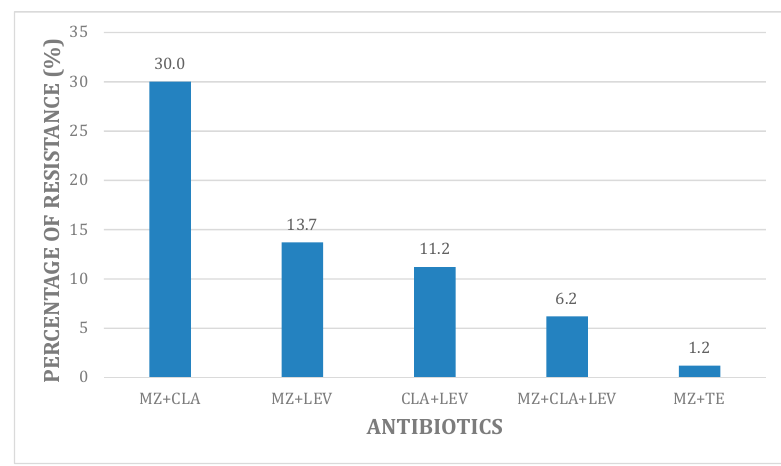
Figure 1. Characteristics of phenotypic antibiotic resistance for Hp strains. Notes: Proportion of phenotypic resistant Hp isolates (%) to the respective antibiotics in an Academic Hospital in Rome (Italy). Abbreviations: MZ: metronidazole; CLA, clarithromycin; LEV, levofloxacin; TE,